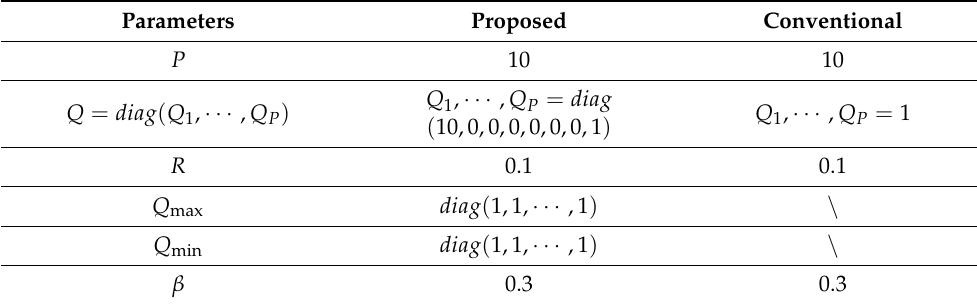
Table 2. The parameters of the two strategies. Parameters